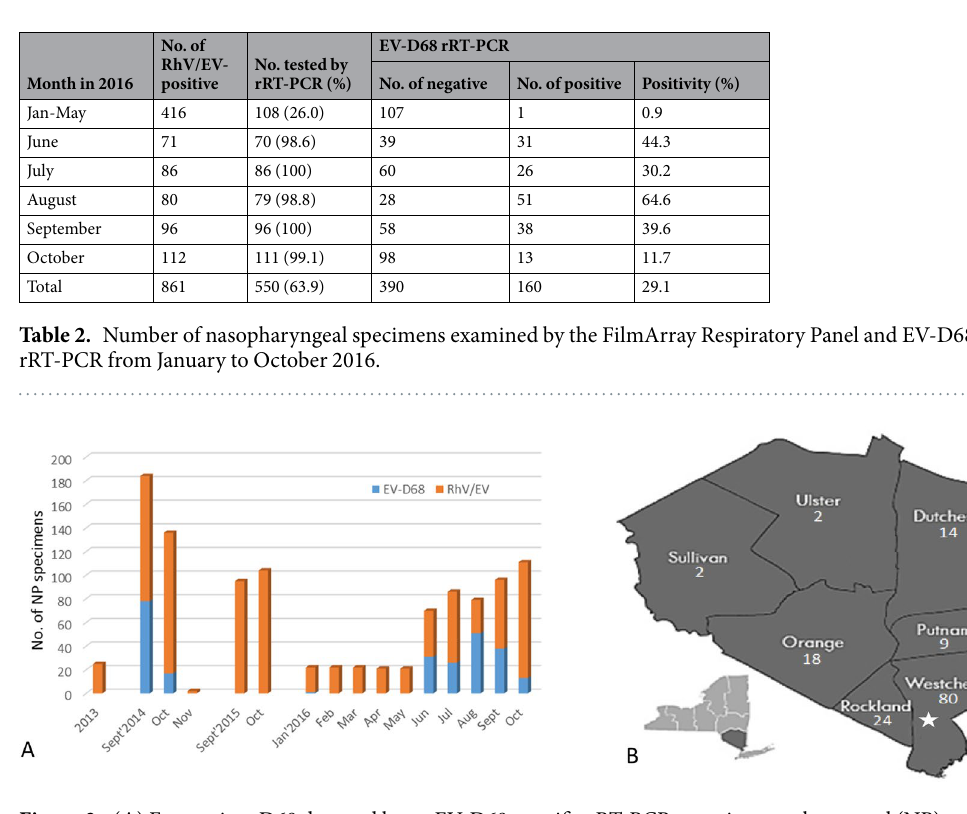
Figure 2. ( A ) Enterovirus D68 detected by an EV-D68-specific rRT-PCR assay in nasopharyngeal (NP) specimens collected from 2013 through October 2016; ( B ) Map of counties in the Lower Hudson Valley, New York and distribution on the number of patients with enterovirus D68 detected from respiratory samples in 2016. One hundred forty-nine (n = 149) of 160 (93.1%) confirmed cases in 2016 were from this region. The star indicates the site of the Westchester Medical Center. Map was adapted with permission from the New York State Department of Environmental Conservation website